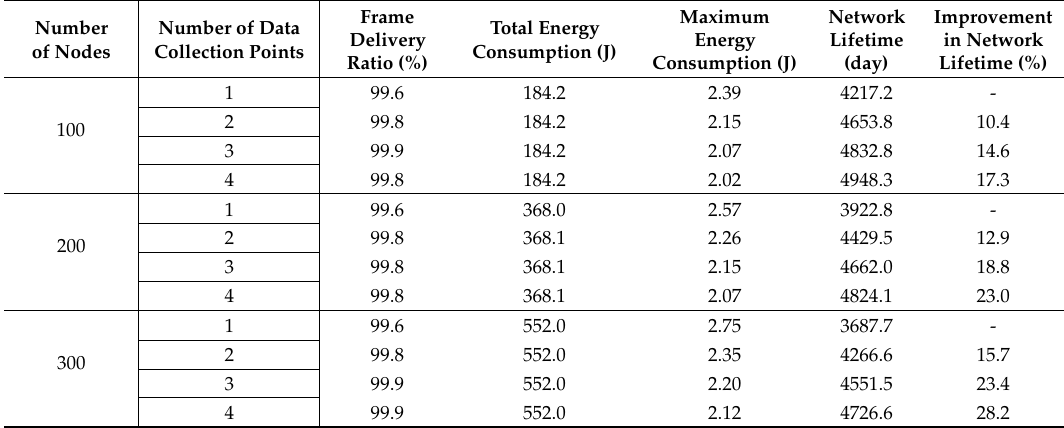
Table 6. Evaluation of SC-Sched in the mobile sink